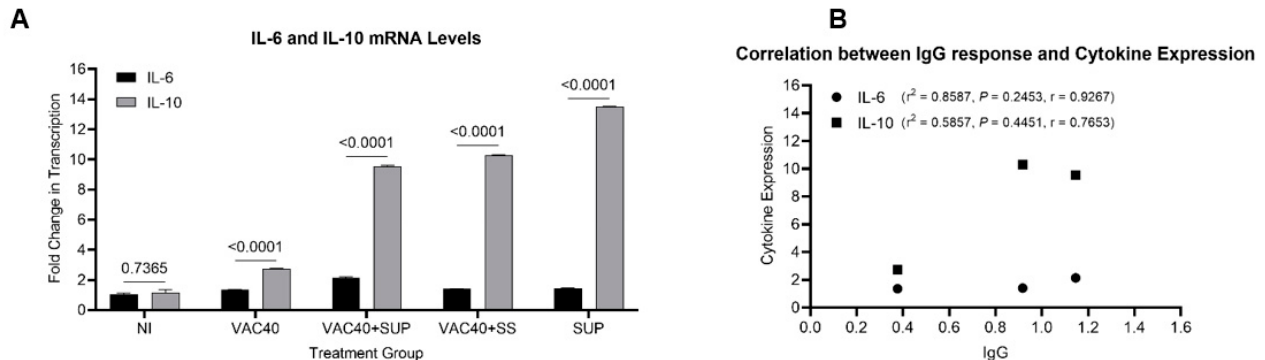
Figure 3. Relative quantification of IL-6 and IL-10 mRNA levels in BALB/c mice. ( A ) Comparison of IL-6 and IL-10 mRNA levels. ( B ) Correlation analysis of SARS-CoV-2 anti-spike IgG and cytokine expression. Unpaired t -tests ( A ) and Pearson correlation analysis ( B ) were performed in GraphPad Prism v.9.2 to compare the differences.